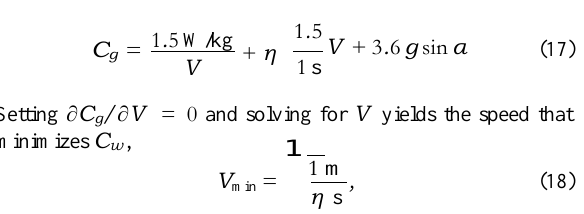
Figure 2. The simplest weight function per unit distance (gross metabolic cost of walking). The correction term in (15) has been computed assuming a mass of M = 70